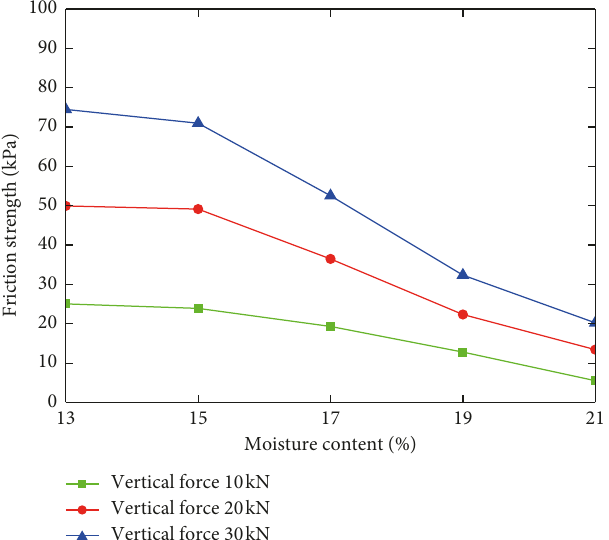
Figure 9: Friction coefficients of concrete with various coatings and soil for different moisture